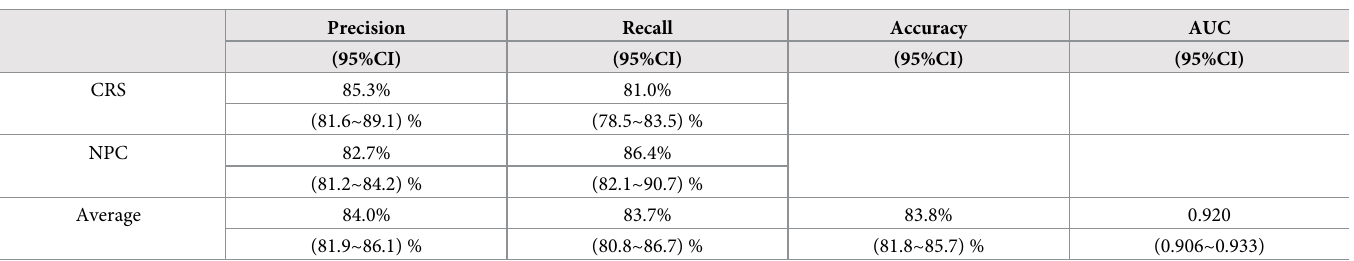
Table 5. Performance of RF: NPC vs CRS.